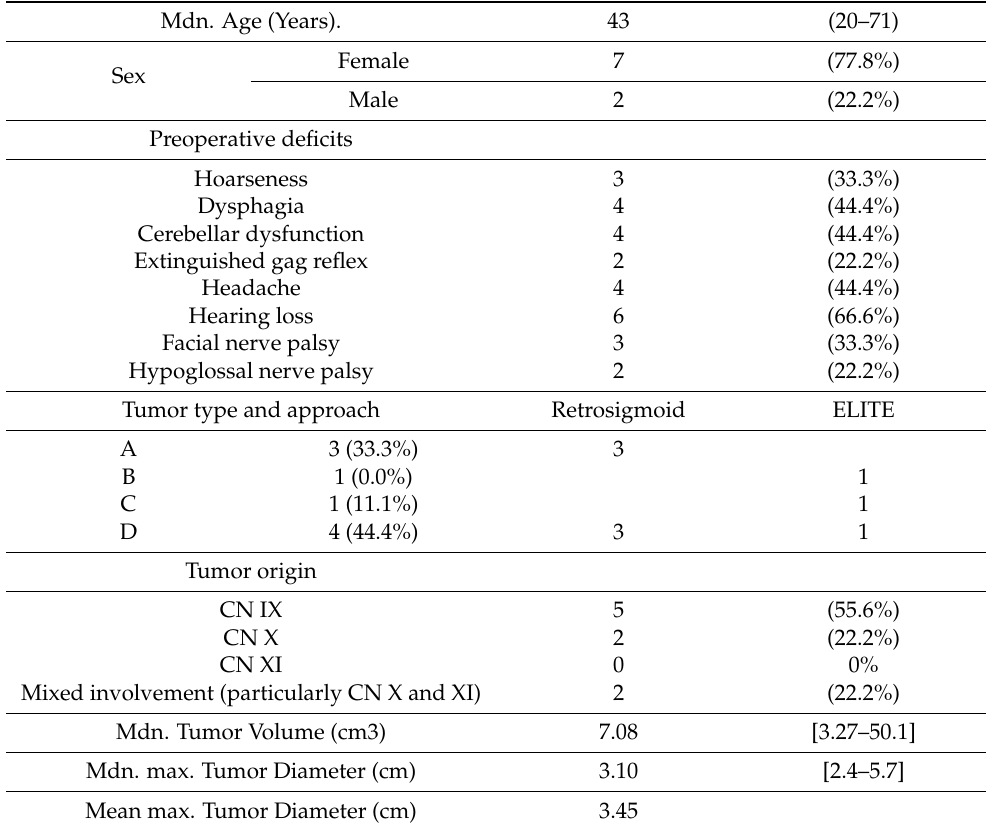
Table 2. Demographics, clinical presentation, and tumor